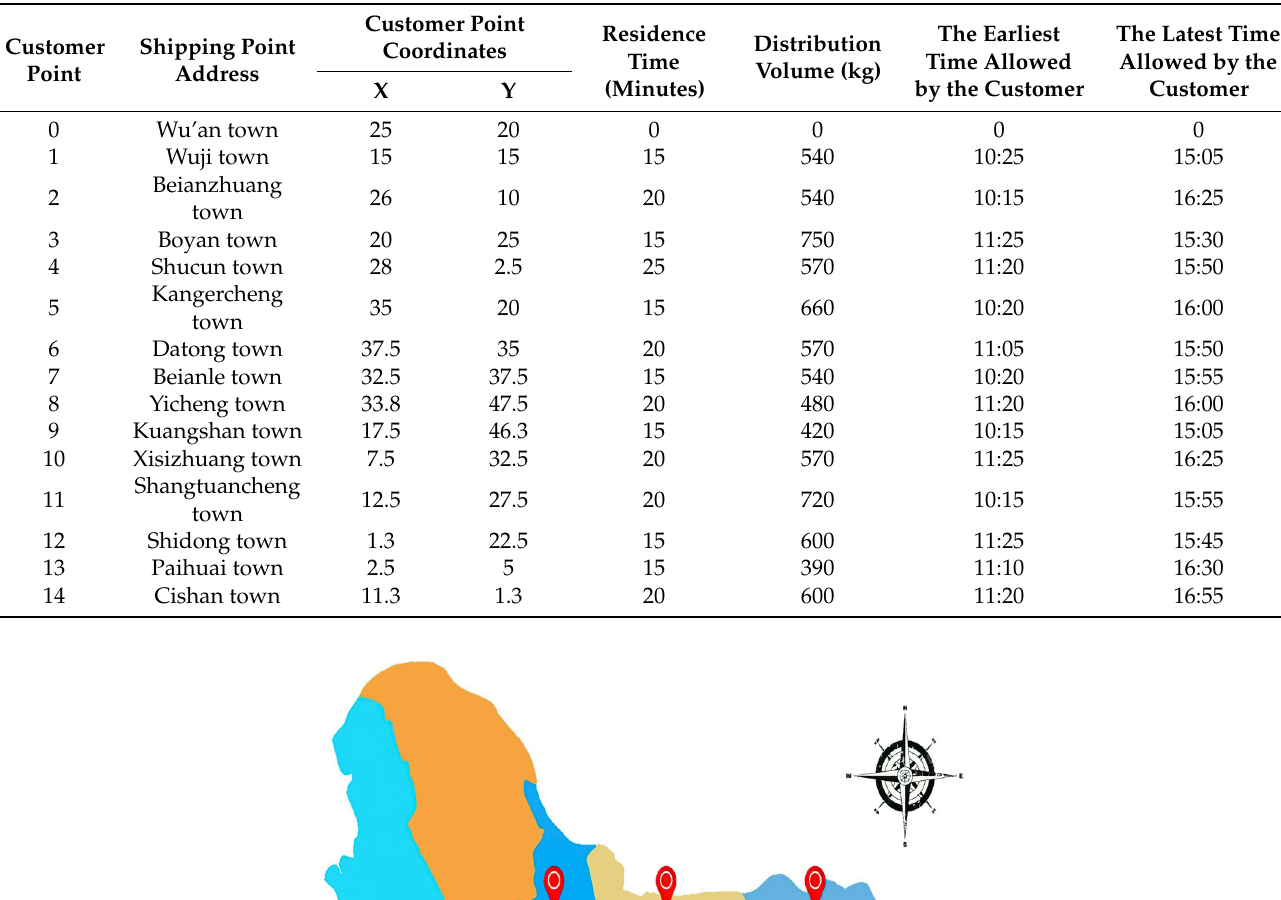
Table 8. Distribution Center and Customer Point Information Sheets.